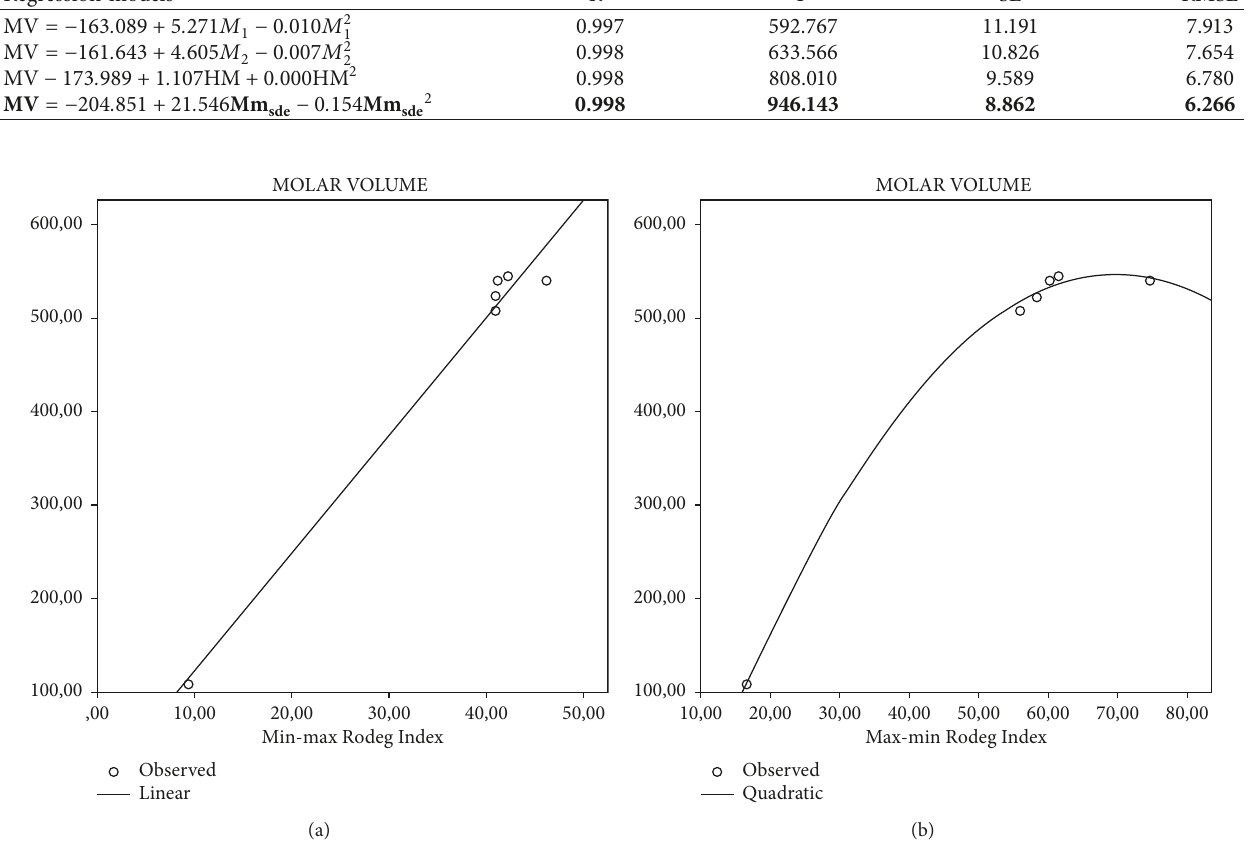
Table 10: The quadratic regression models that give the best estimate for the molar volume. Regression models